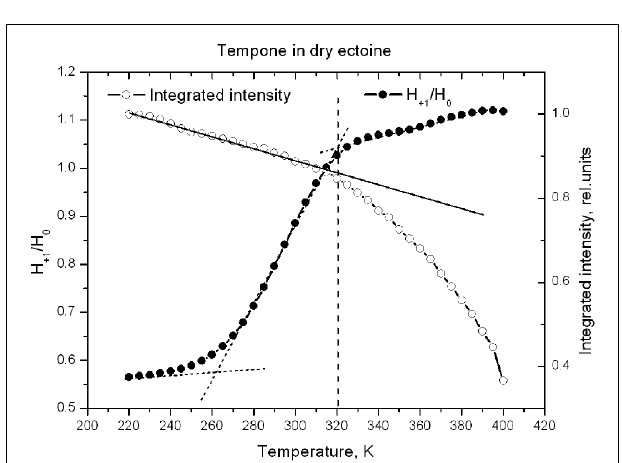
FIGURE 10 |Temperature dependence of H +1 /H 0 and normalized integrated intensity ofTempone spectra in dry ectoine.